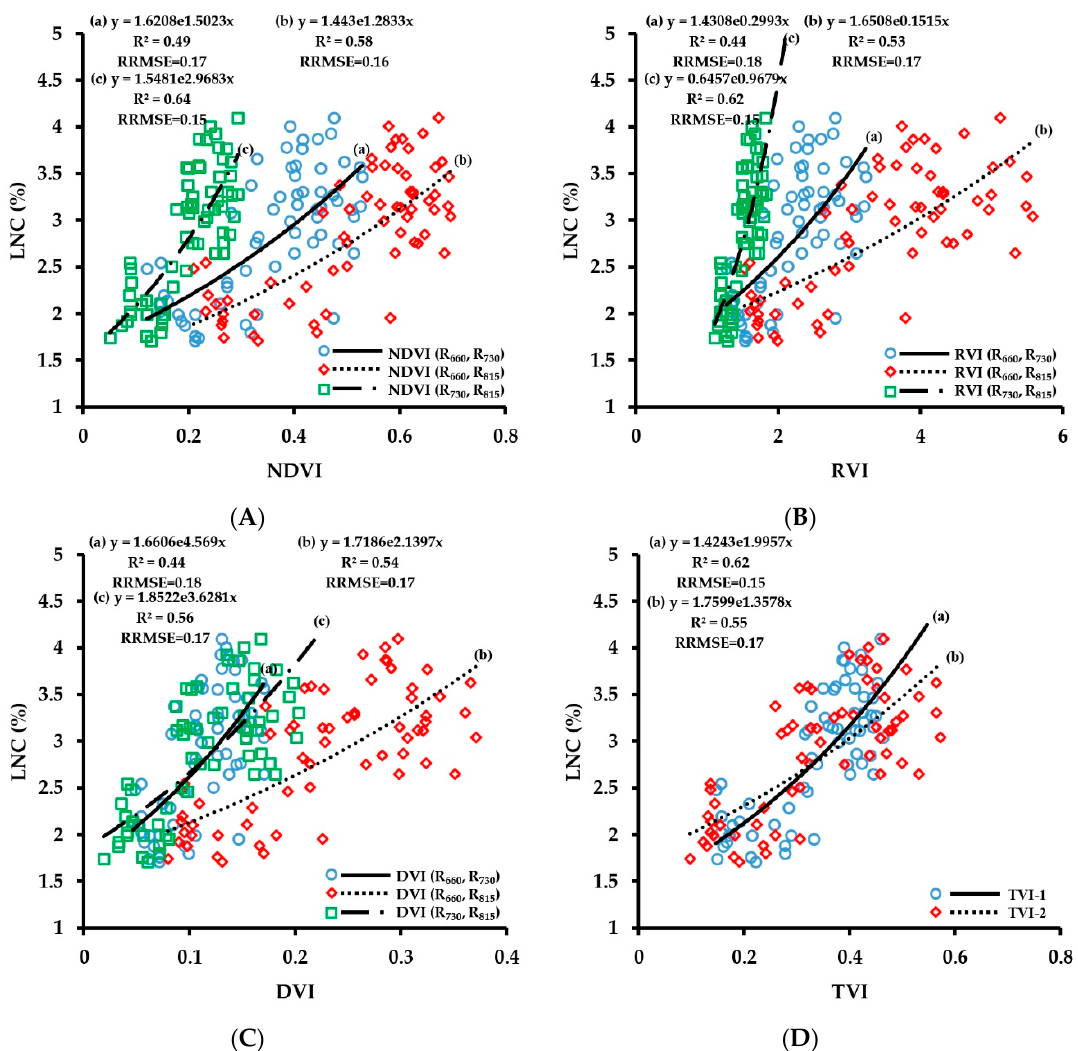
Figure 10. Fitting curve of NDVI ( A ), RVI ( B ), DVI ( C ) and TVI ( D ) to LNC of wheat.